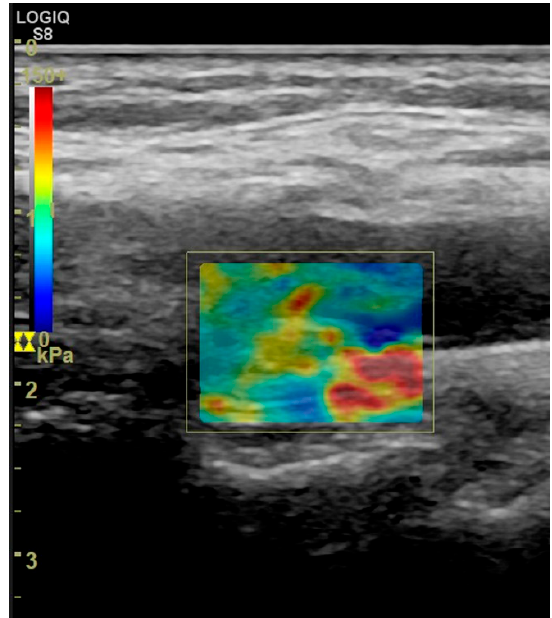
Figure 10. Shear ‐ wave elastography image showing an echogenic plaque. The plaque yields high Figure 10. Shear-wave elastography image showing an echogenic plaque. The plaque yields high shear wave velocity values (yellow to red colour in left ‐ hand scale), suggesting that this is a stiff shear wave velocity values (yellow to red colour in left-hand scale), suggesting that this is a stiff plaque containing fibrous and calcific tissue. plaque containing fibrous and calcific